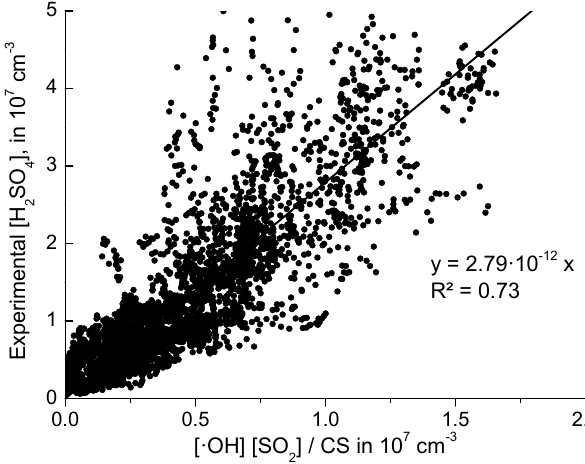
(cid:113) Figure 1. Definition of the OH proxy based on the experimental correlation with the global radiation flux during EUCAARI 2008 (see also Eq. 1).